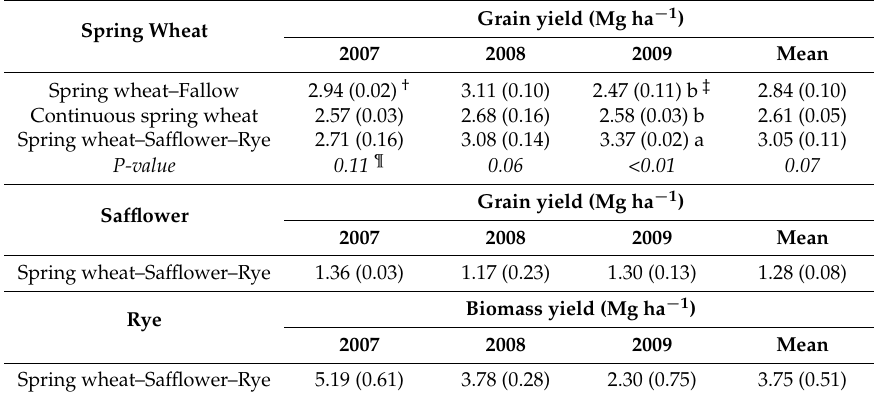
Table 1. Crop yields for cropping systems evaluated in study,